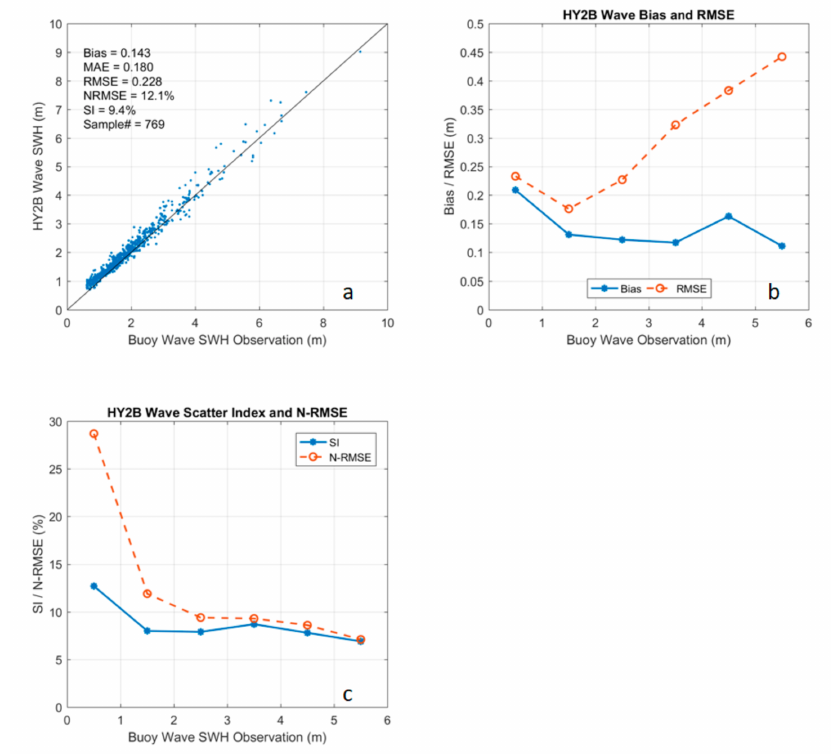
Figure 2. The validation of HY2B significant wave height (SWH) against NDBC buoys. ( a ) Indicates the scatters and the statistical parameters; ( b ) indicates the bias and RMSE distribution with the SWH value; ( c ) indicates the scatter index (SI) and normalized root mean square error (NRMSE) distribution with the SWH